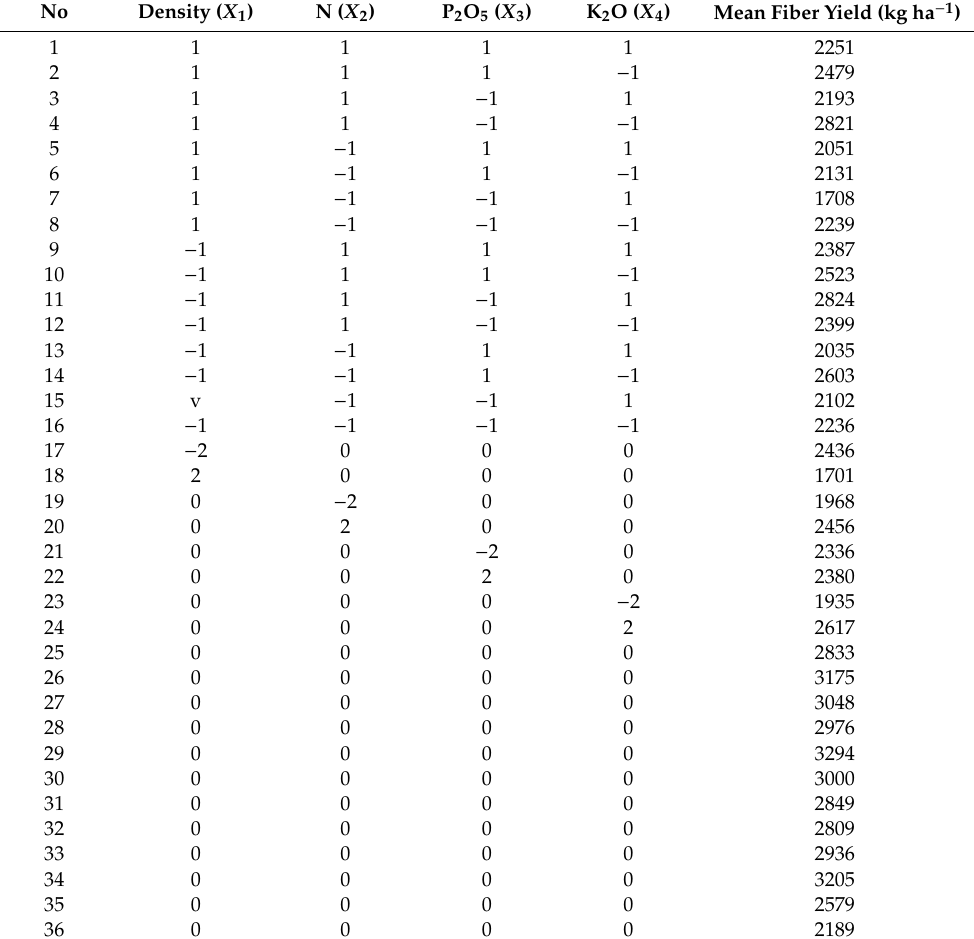
Table 2. Structure matrix and the production results from 2016 and 2017.